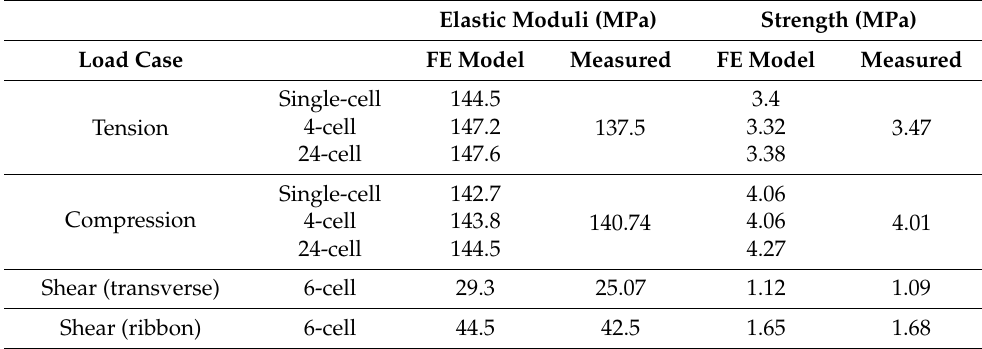
Table 3. Comparison of the FE-predicted and measured property values of the polymer HC core structure under the out-of-plane loadings.